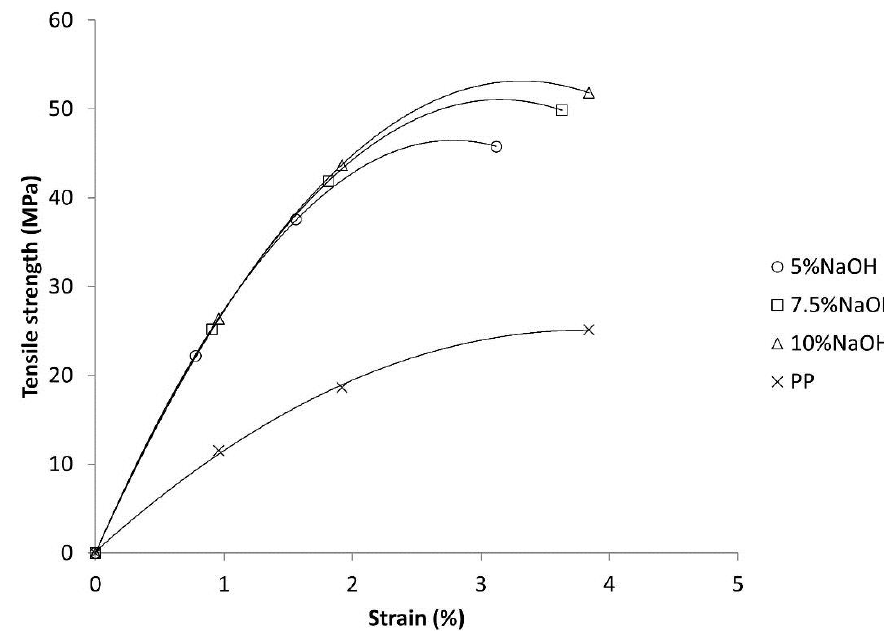
Figure 5. Mean stress-strain curves of the composites and the matrix. The intermediate strain points used to solve the Kelly-Tyson equation are marked above the corresponding curve.